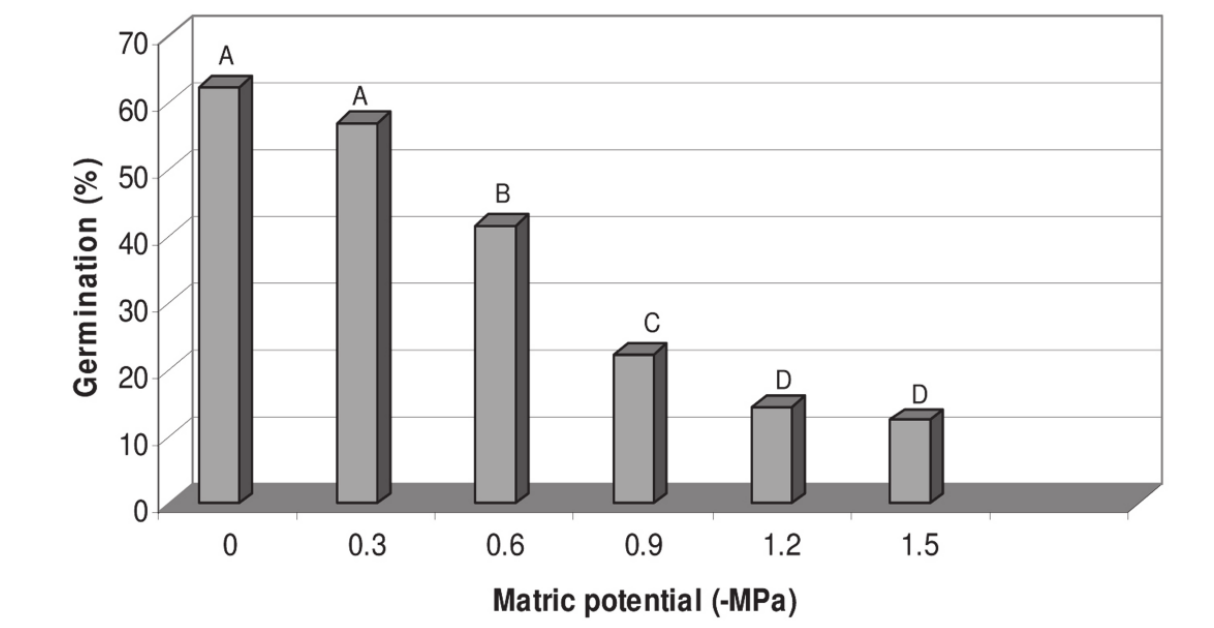
Fig. 2. Effect of matric potential on germination (%) of Verticillium dahliae microsclerotia. Significant differences between treatments are indicated by different letters at P ≤ 0.01 by Duncan’s Multiple Range